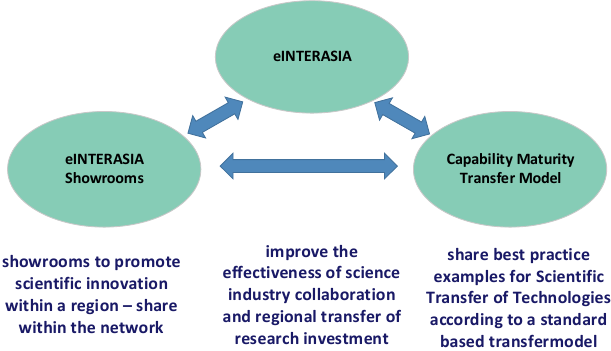
Fig. 9. Relation between eINTERASIA Showrooms and Capability Maturity in Knowledge and Technology